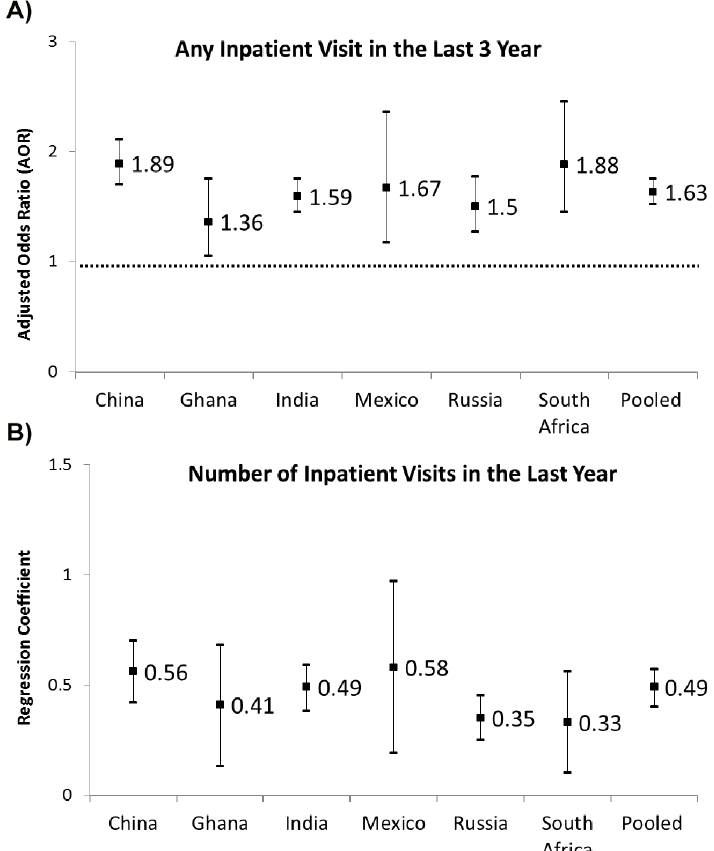
Fig 3. Association between number of NCDs and healthcare utilisation- any inpatient utilisation (Fig 3a); Association between number of NCDs and healthcare utilisation- number of inpatient visits (Fig 3b). Figures in the last column are coefficients and 95% CI for the variable “ number of NCD ” from regression models adjusting for all covariates. Logistic model is used to estimate any visit for outpatient/inpatient service, and negative binomial model is used for number of visit/ hospitalisation days